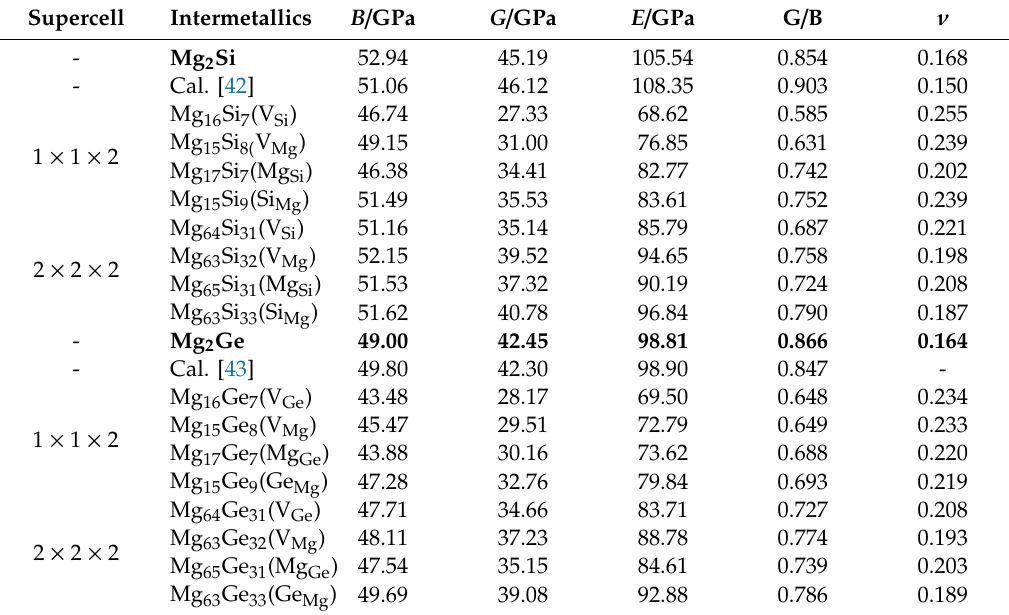
Table 6. Lists the calculated bulk modulus, B.; the shear modulus, G.; Young’s modulus, E.; Poisson’s ratio ν and G / B